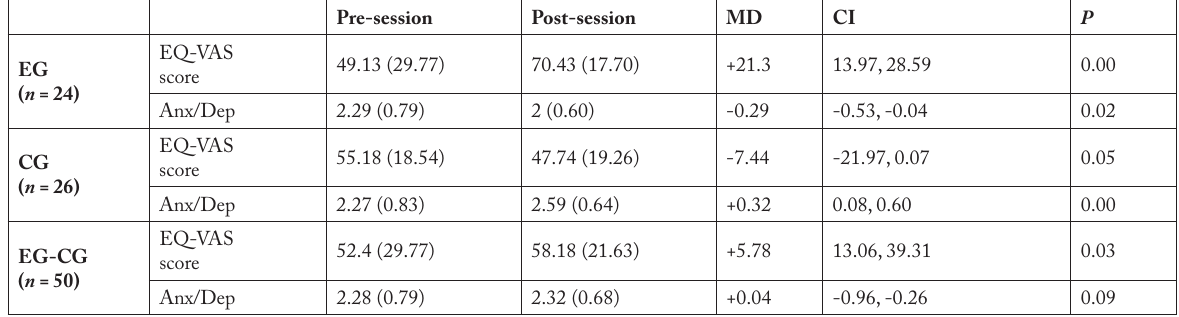
Table 2. Student t-test between and within groups for self-perceived health state and anxiety/depression